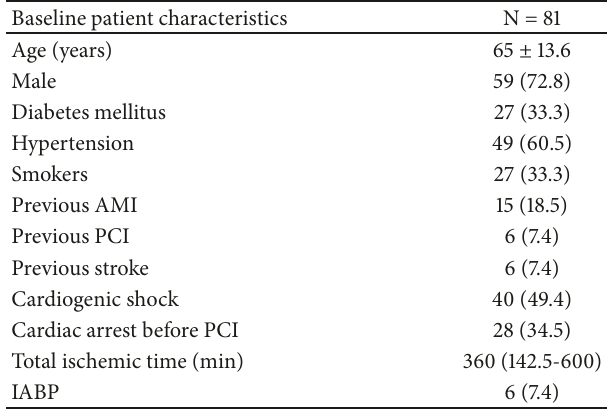
Table 1: Baseline clinical and ECG characteristics. Values are mean ± standard deviation, median (interquartile range), or number (%). AMI = acute myocardial infarction, IABP = intra-aortic balloon pump, IQR = interquartile range, N = number, and PCI = percutaneous coronary intervention.